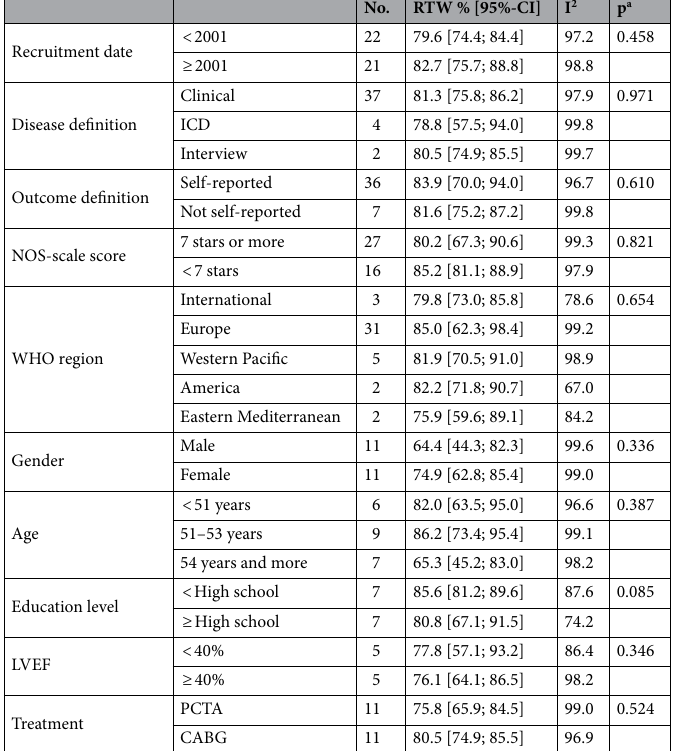
the clinical and socio-professional characteristics of the patients are summarized in Supplementary Table S3 online. RTW prevalence estimates by time of follow-up were similar for all types of events. Regarding acute